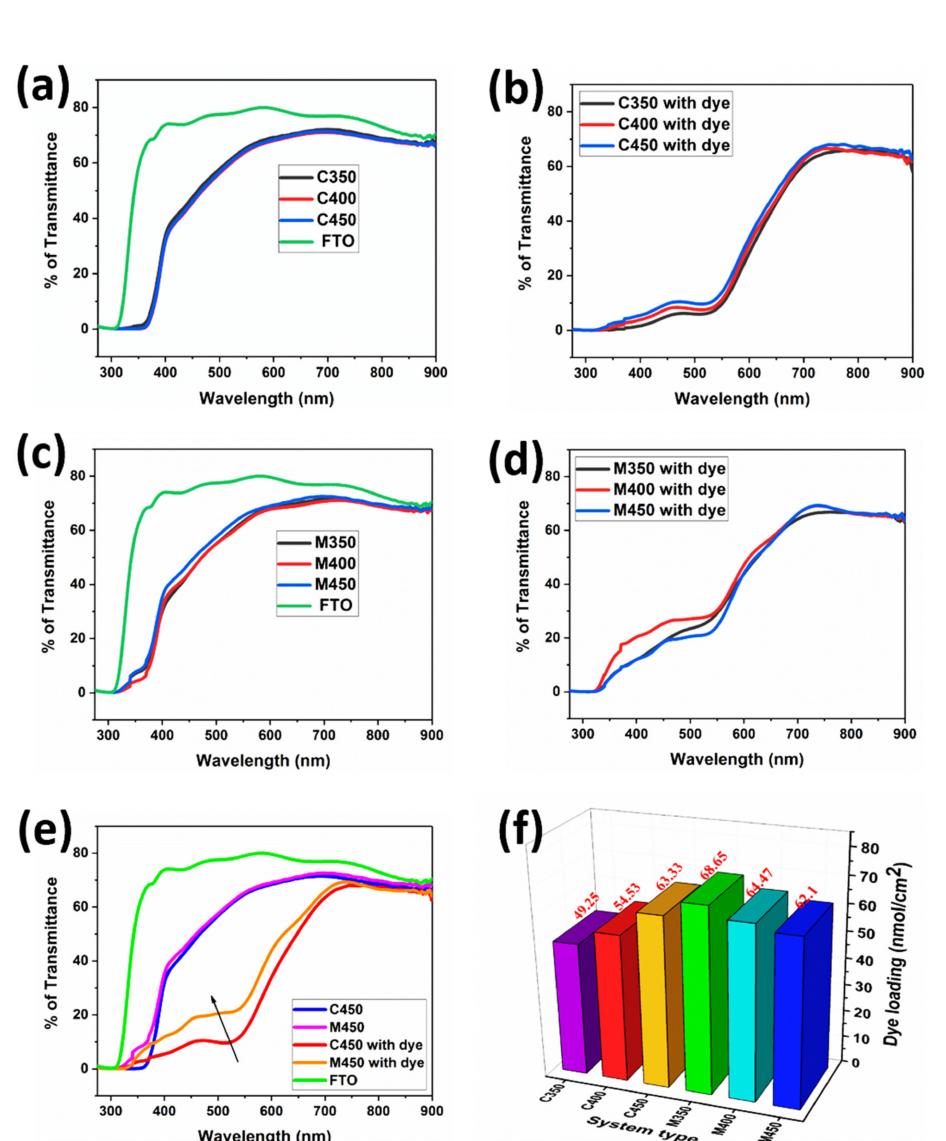
Figure 2. Transmittance spectra of ( a , c ) Conventionally and microwave sintered titania films without dye, ( b , d ) Conventionally and microwave sintered titania films with dye, ( e ) Transmittance spectra of conventional and microwave sintered films at 450 ◦ C with and without dye, and ( f ) Dye-loading profile of various